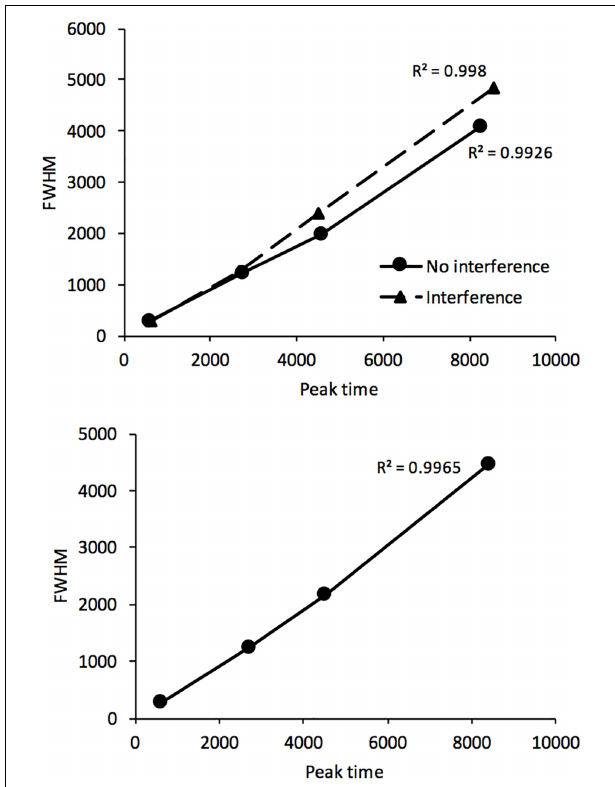
FIGURE 5 | FWHM plotted against peak time in the long-term memory test with or without an interference task (top) or these two conditions combined (bottom).